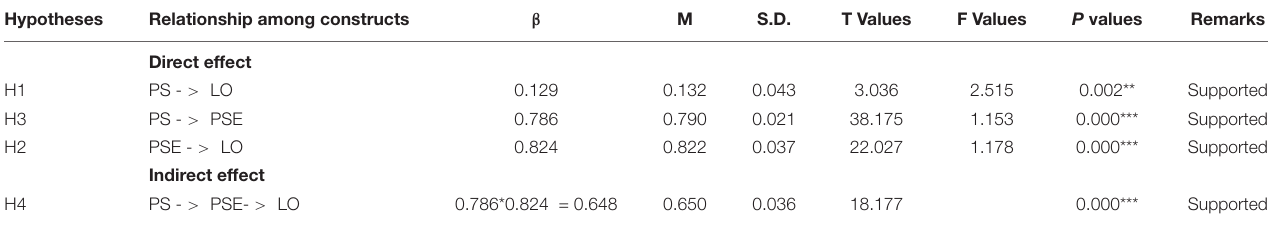
TABLE 4 | Results of the structural equations